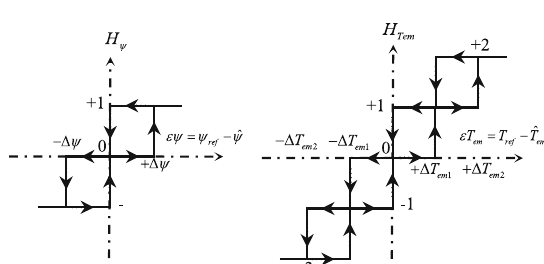
Fig. 5 Hysteresis comparators used to control flux and